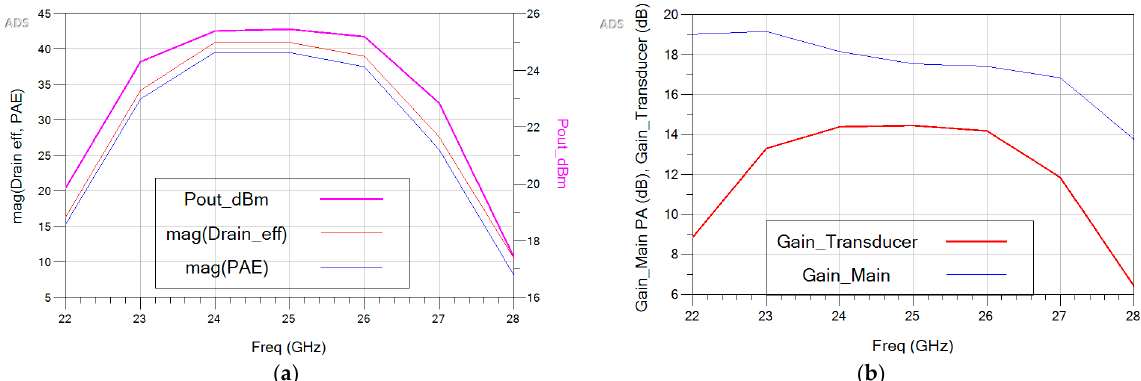
Figure 9. ( a ) Simulated PAE and drain efficiency magnitudes, along with the output power (dBm) vs. frequency, ( b ) the power gain of the main PA, and the transducer power gain of the DPA in terms of frequency.